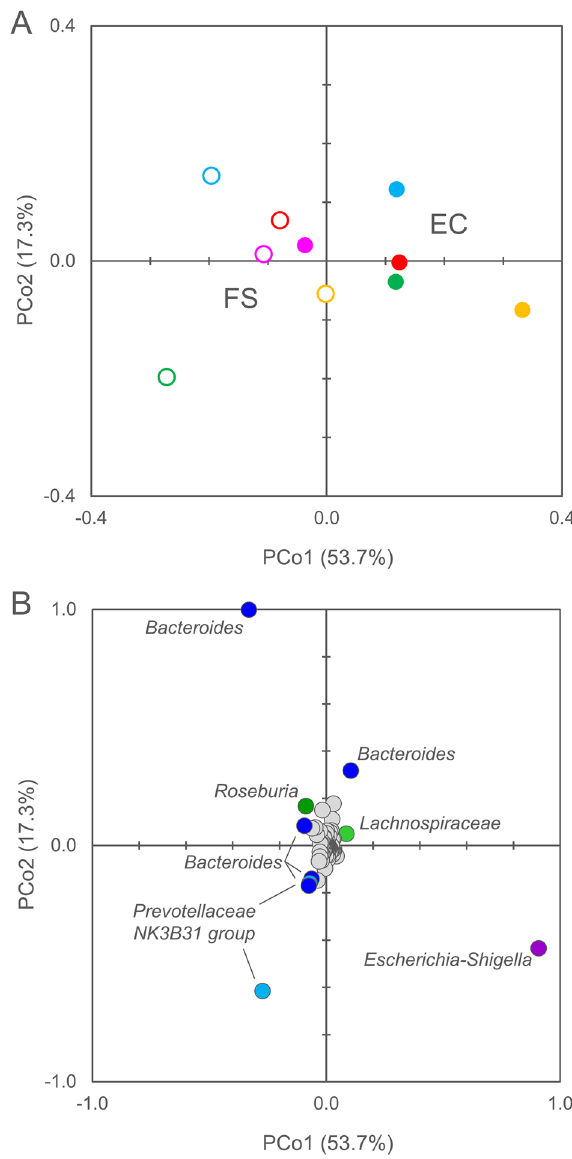
Figure 1. Beta diversity analysis of the microbiota in FS and EC samples. ( A ) PCo1-PCo2 visualization of distances computed with Weighted Unifrac, that considers phylogenetic relationships among bacteria. Symbols: FS, empty circle; EC, full circle; different colors correspond to different subjects (1, fuchsia; 2, cyan; 3, green; 4, red; 5, yellow). ( B ) PCo1-PCo2 visualization of the contribution of each ASV. The 10 ASVs exerting the highest effect on PCo1 are labelled and colored according to their phylum (Firmicutes, green; Bacteroidetes, blue; Proteobacteria,